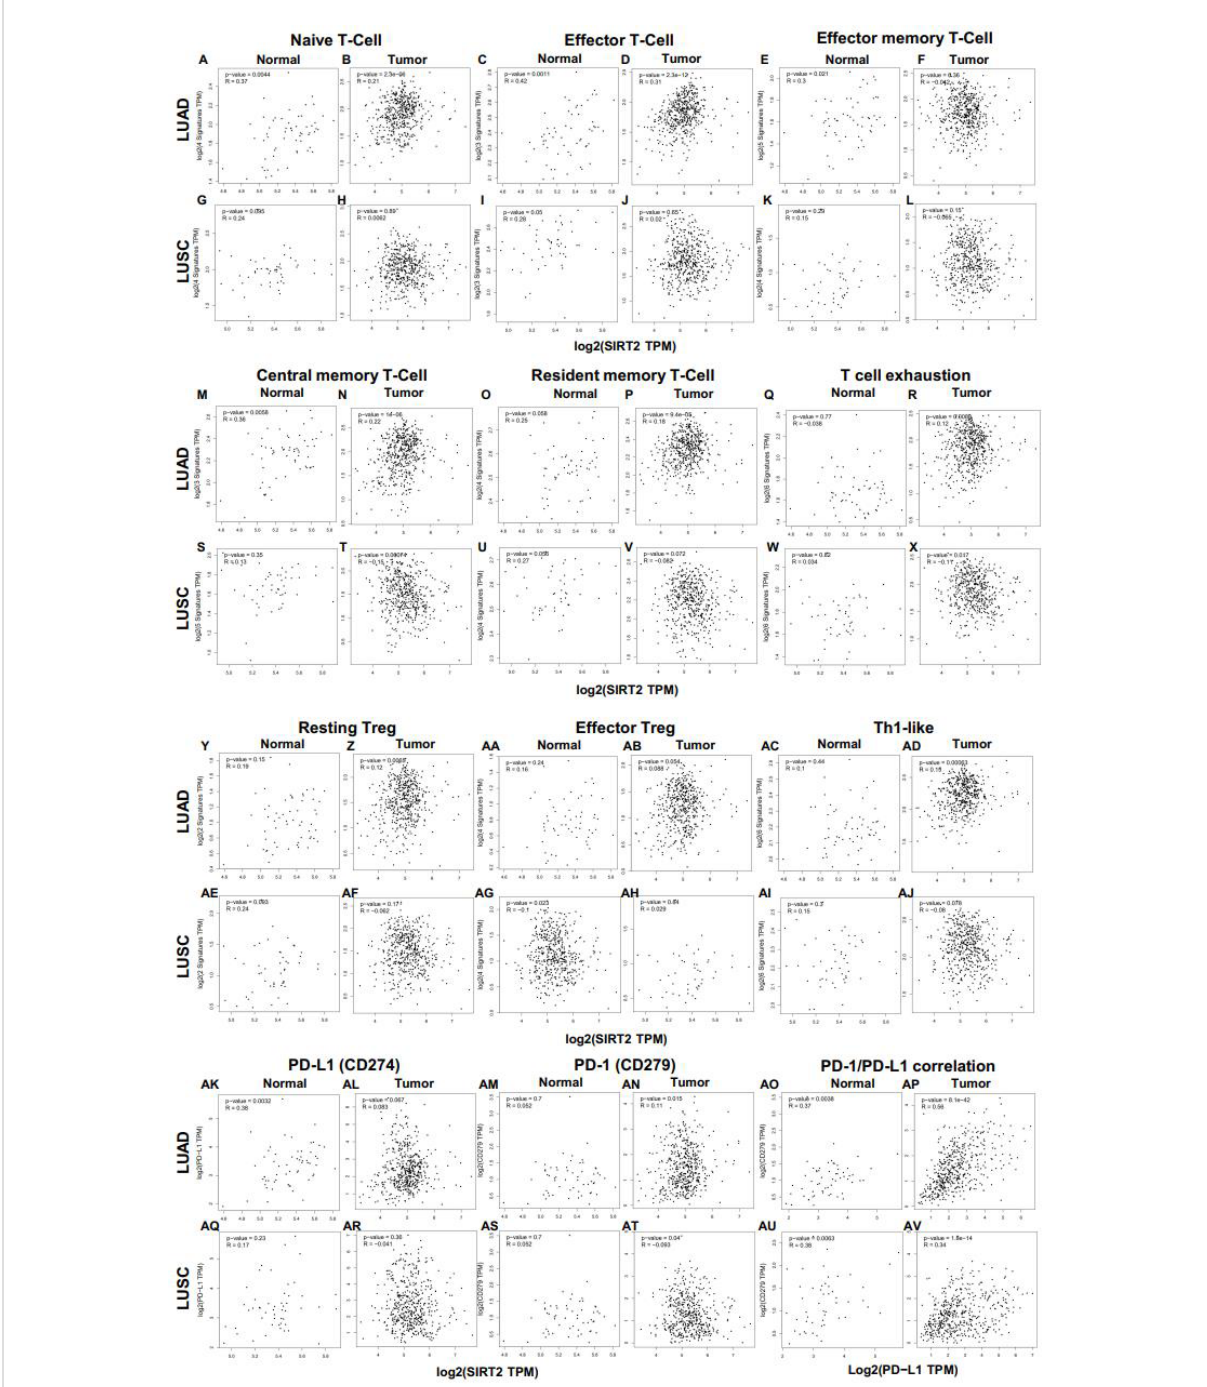
FIGURE 6 Correlation between SIRT2 expression and various immune cells and PD-1/PD-L1 in normal and tumor tissue of LUAD and LUSC. (A-R) Scatterplots of correlations between SIRT2 expression and naive T-Cell (A, B) , effector T-Cell (C, D) , effector memory T-Cell (E, F) , central memory T-Cell (M, N) , resident memory T-Cell (O, P) , T cell exhaustion (Q, R) , resting Treg (Y, Z) , effector Treg (AA, AB) , Th1-like (AC, AD) cells and PD-1/PD-L1 axis (AK-AP) in the normal and tissue of LUAD; Scatterplots of correlations between SIRT2 expression and gene markers of naive T-Cell (G, H) , effector T-Cell (I, J) , effector memory T-Cell (K, L) , central memory T-Cell (S, T) , resident memory T-Cell (U, V) , T cell exhaustion (W, X) , resting Treg (AE, AF) , effector Treg (AG, AH) , Th1-like (AI, AJ) cells and PD-1/PD-L1 axis (AQ-AV) in